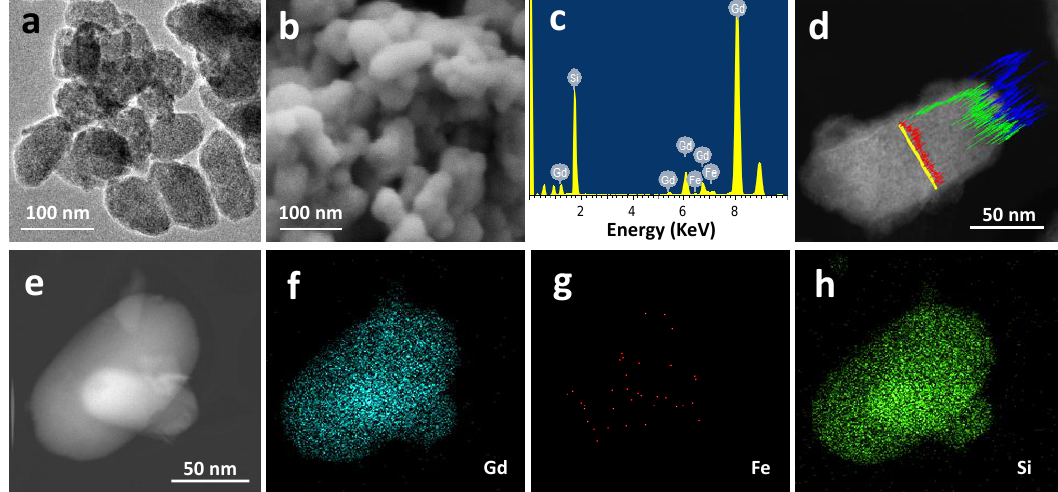
Figure 3. Electron microscopy study of GdSi nanorods obtained by alkaline transformation of GdFe precursor. ( a – b ): TEM ( a ) and FESEM ( b ) images of GdSi nanoparticles. ( c ) EDS elemental analysis. ( d ) STEM image with EDS line scans. Legend: blue line=Gd; red line=Fe; green line=Si. ( e – h ) STEM image ( e ) and EDS mapping pictures of two GdSi nanorods ( f – h ).